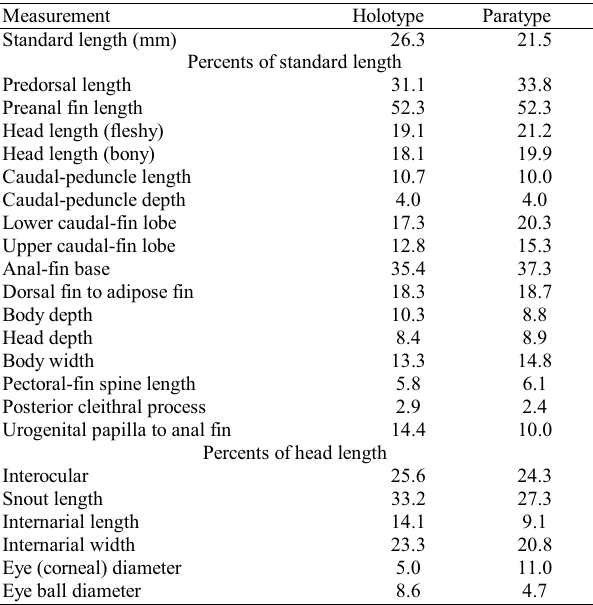
Table 1. Morphometric data of Gladioglanis anacanthus .